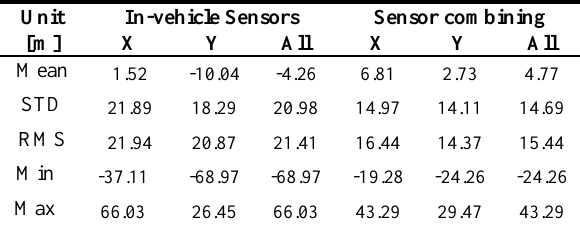
Table 15. Error statistics of the estimation